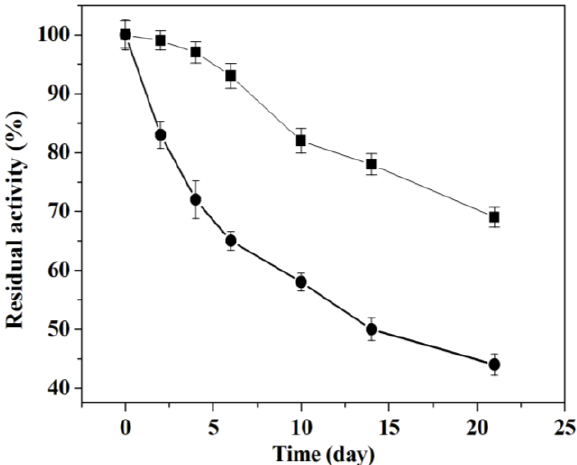
Figure 7. Storage stability of the immobilized (  ) and free trypsin (●). For free trypsin, the specific activity (0.46 μmol min −1 mg −1 ) at 0 h was taken to be 100%. For